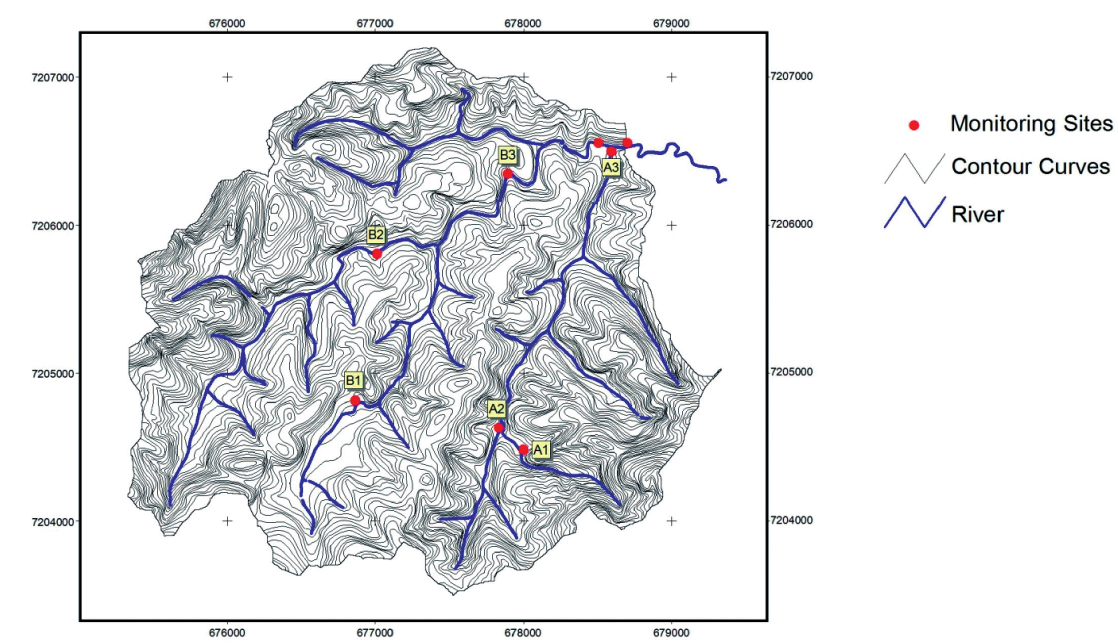
Figure 5. Contour lines and monitoring sites in the Campestre